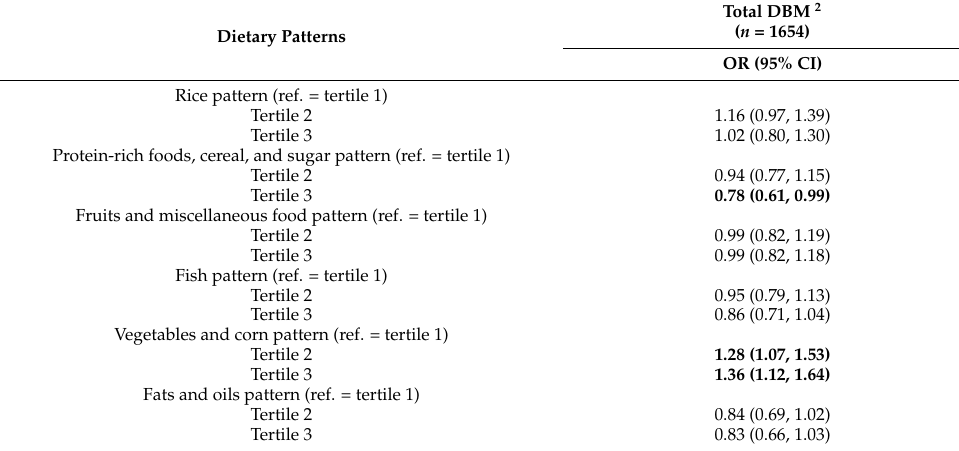
Table 6. Logistic regression models for double burden of malnutrition across tertiles of dietary pattern scores among females 1